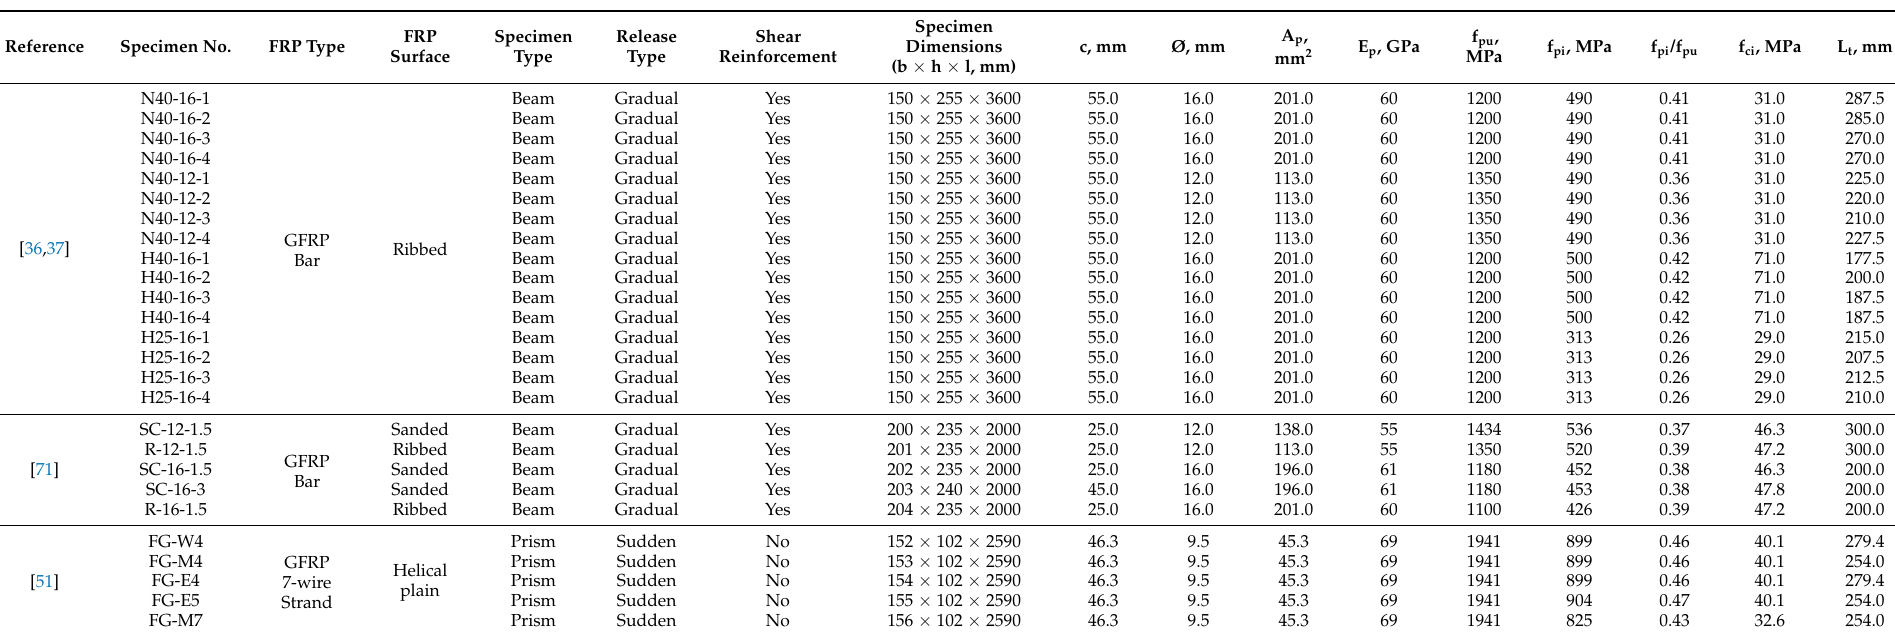
Table 1. Geometrical, mechanical properties of the material and transfer lengths of specimens with pretensioned GFRP reinforcement.